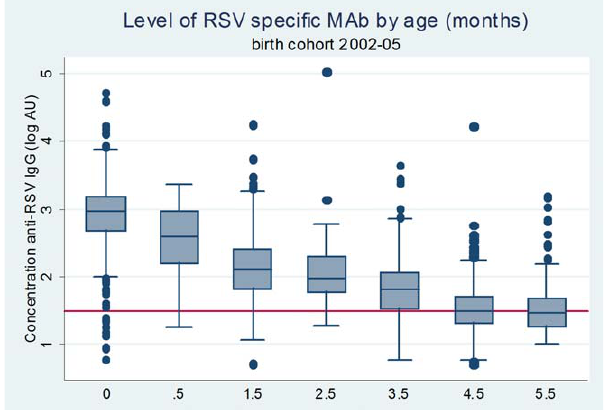
Figure 2. The level of RSV-specific matAb by age (months) in a birth cohort, Kilifi Kenya. Box plot of log 10 AU Ab levels for age categories defined as 0 months (cord), 0.5 ( . 0- , 1), 1.5 (1- , 2), 2.5 (2- , 3), 3.5 (3- , 4), 4.5 (4- , 5) and 5.5 (5- , 6) months. The red